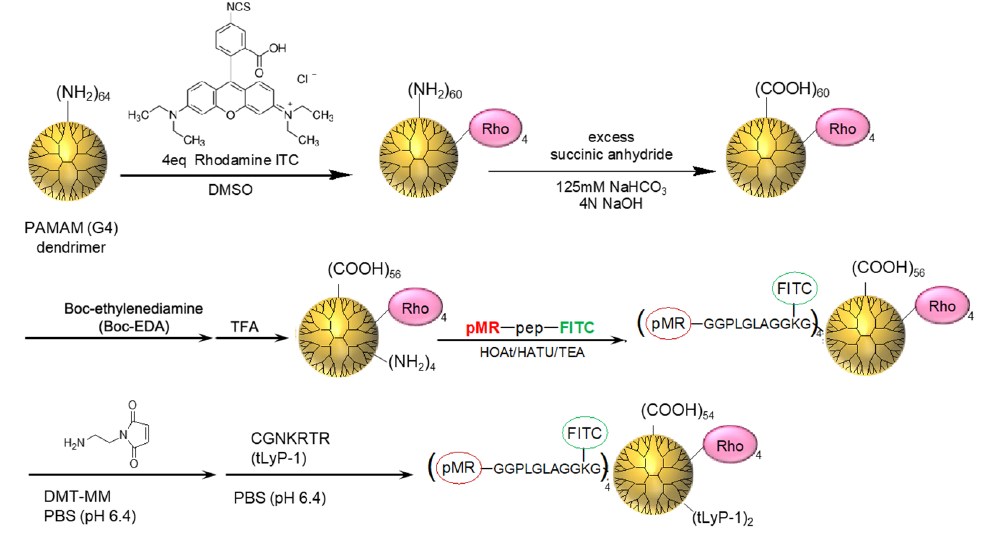
Figure 2. Synthesis of the dual-color fluorescent carboxyl-terminal dendrimer featuring a tumor-homing peptide. TFA, trifluoroacetic acid; HOAt, 1-hydroxy-7-azabenzotriazole; HATU, 1-[bis(dimethylamino)methylene]-1H-1,2,3-triazolo[4,5-b]pyridinium 3-oxide hexafluorophosphate; TEA, trimethylamine; DMT-MM, 4-(4,6-dimethoxy-1,3,5-triazin-2-yl)-4-methylmorpholinium chloride.